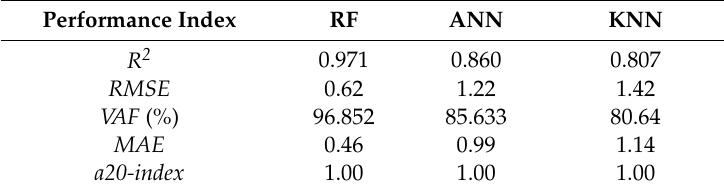
Figure 14. Actual and predicted values for the models selected in validation phase. Table 3. Performance Assessment for the Validation